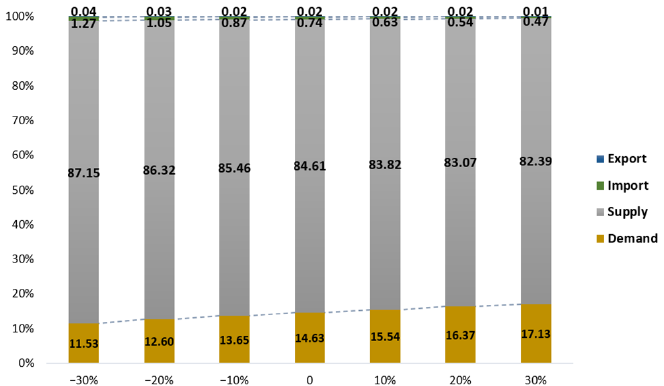
Figure 6. Numerical simulation results of garlic.